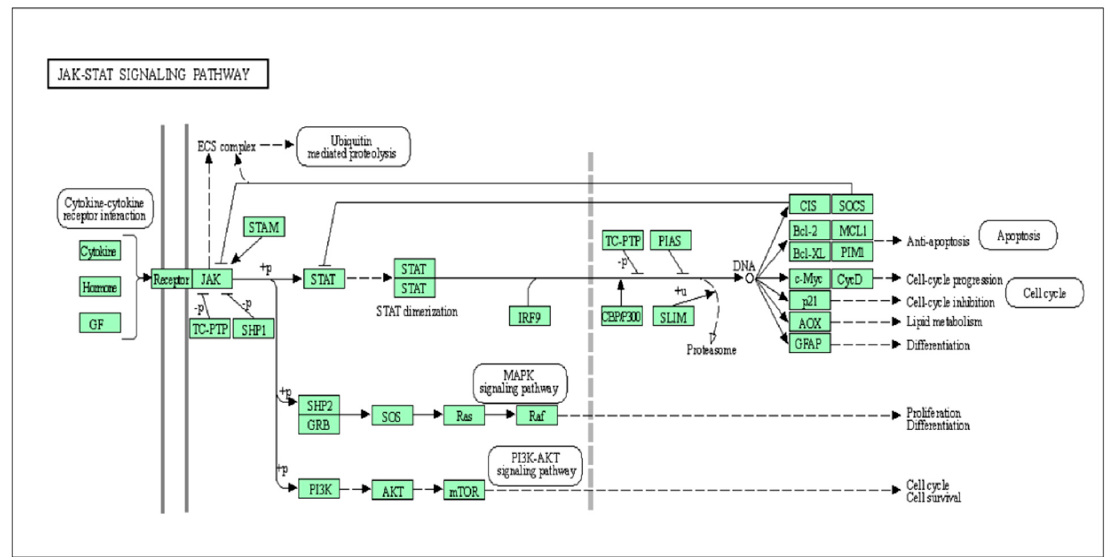
Figure 1. The regulation of the cytokine-activated Janus kinase (JAK)–signal transducer and activator of transcription (STAT) pathway by cytokines, hormones, and growth factors; engagement of the JAK-STAT pathway in the process of differentiation, survival, and proliferation through the modification in cellular gene expression.